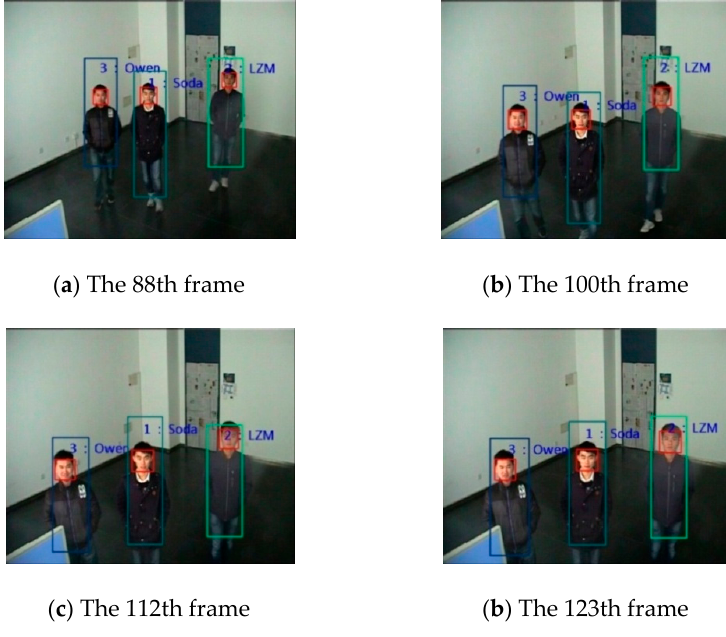
Figure 6. The recognition results.